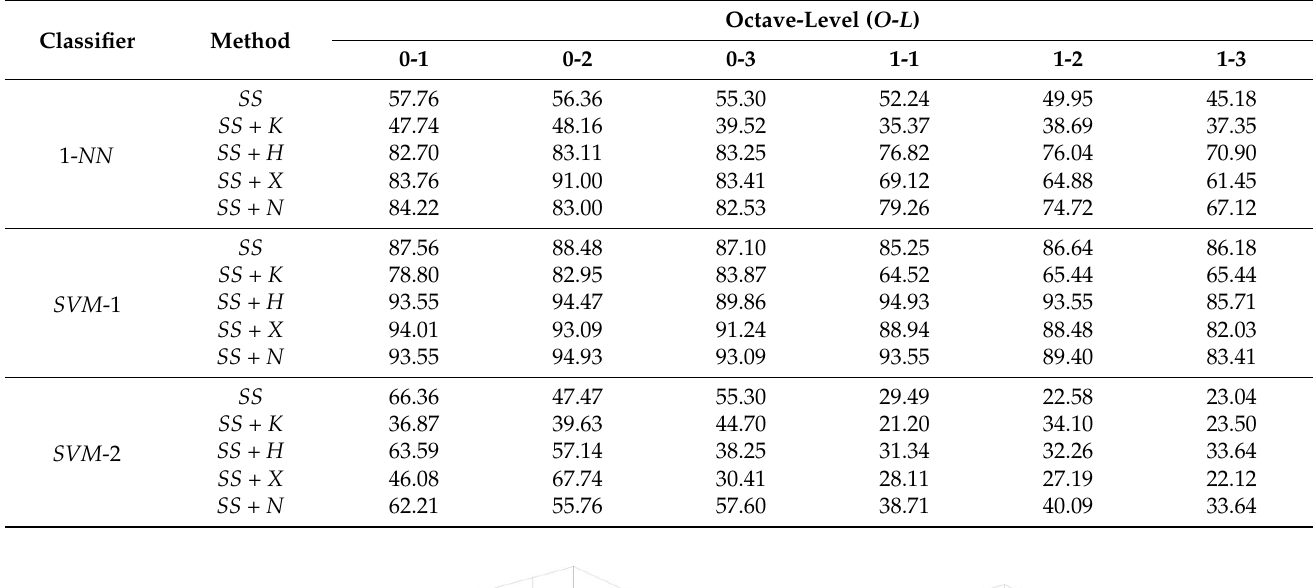
Table 8. The detailed accuracy (%) results of the scale-space method and its combination with a curvature-based method ( SS, SS + K, SS + H, SS + X, and SS + N ) on the EYB dataset for the eyebrow images.